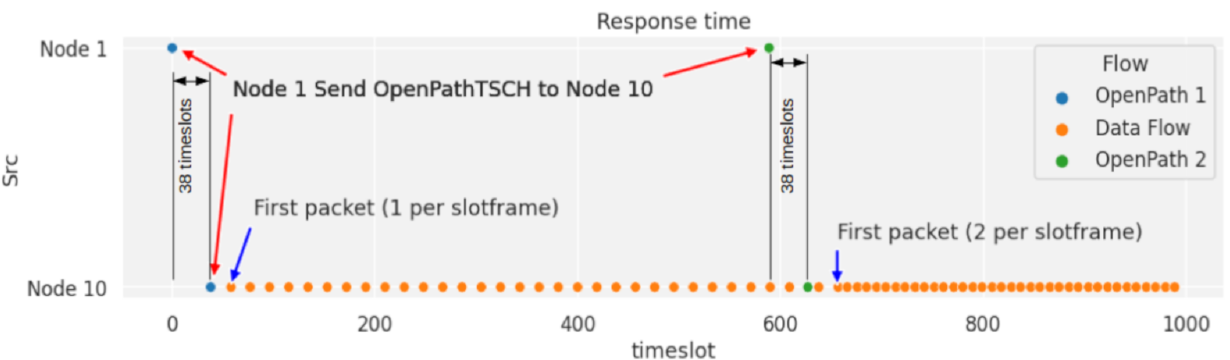
Figure 10. Response and change of scheduling